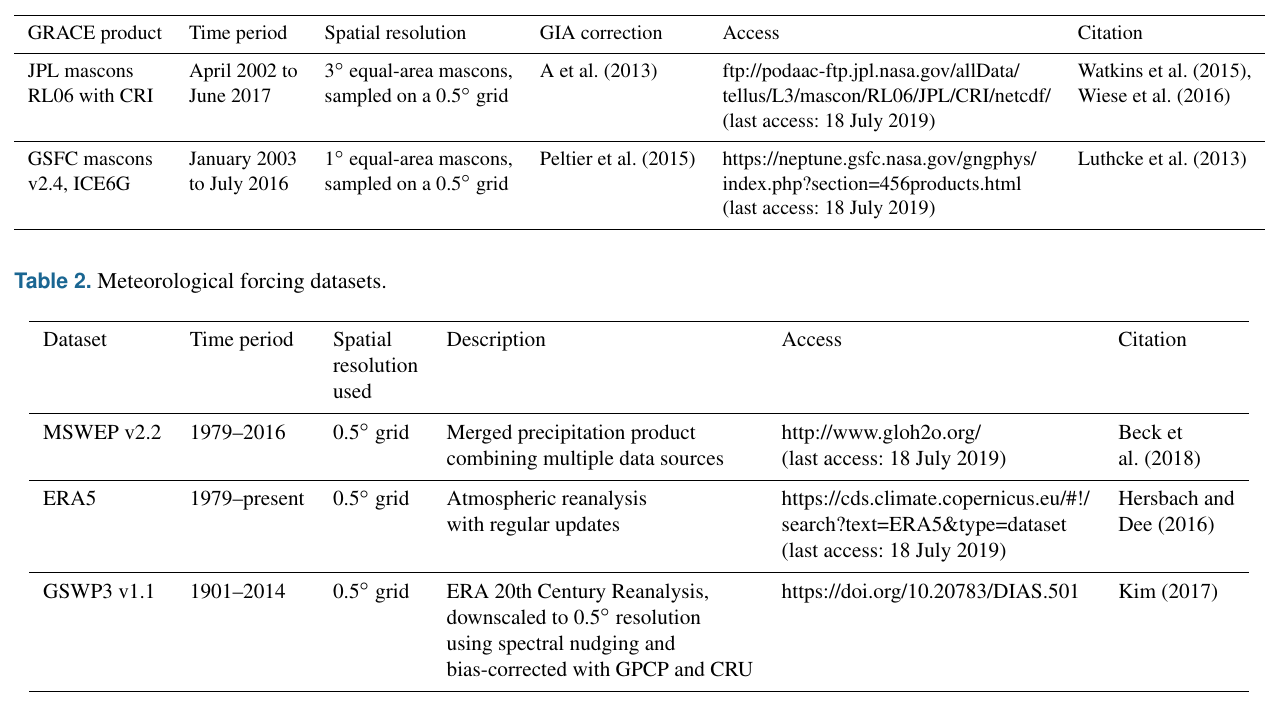
Table 1. GRACE datasets used for model calibration.